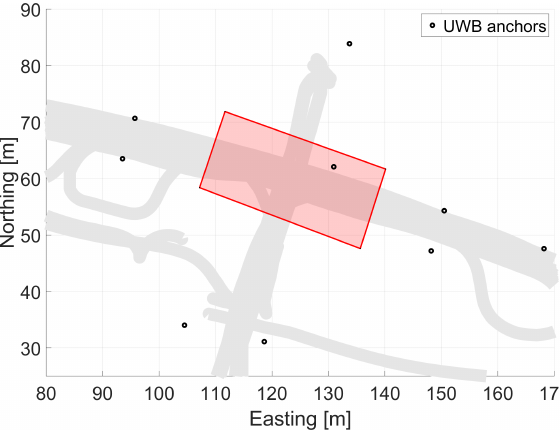
Figure 4. Example 3 of car